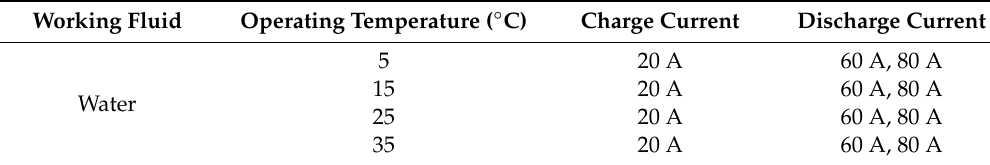
Table 2. Testing